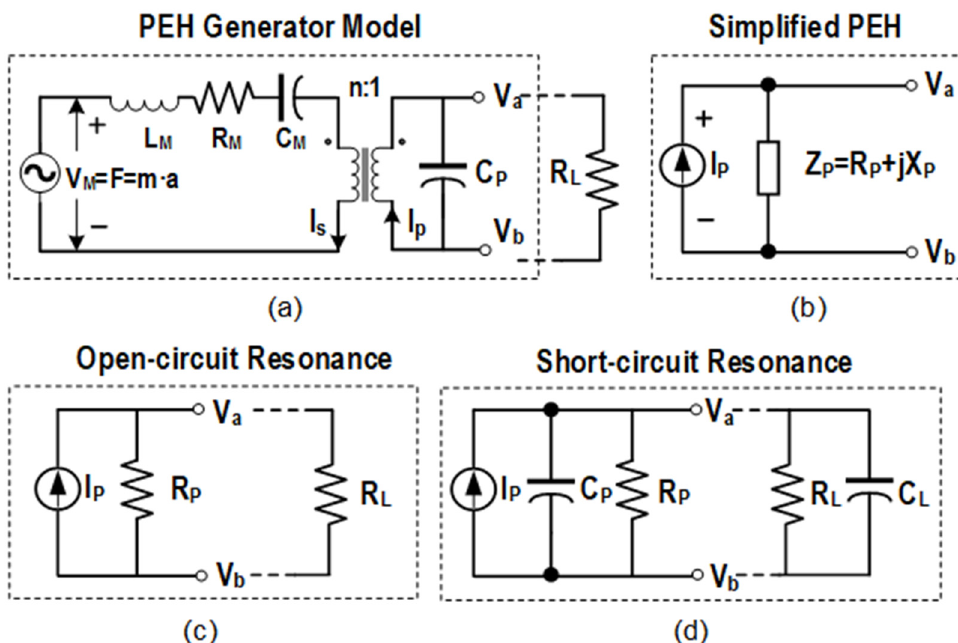
Figure 3. ( a ) Mechanical and electrical domain coupled models for piezoelectric energy harvesters, ( b – d ) Equivalent circuit of piezoelectric energy harvester when it vibrates at full frequency range, open-circuit resonance frequency and short-circuit resonance frequency, respectively.